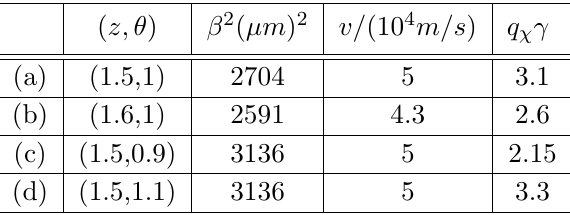
Table 1 . Used parameters in (cid:12)gure 4.